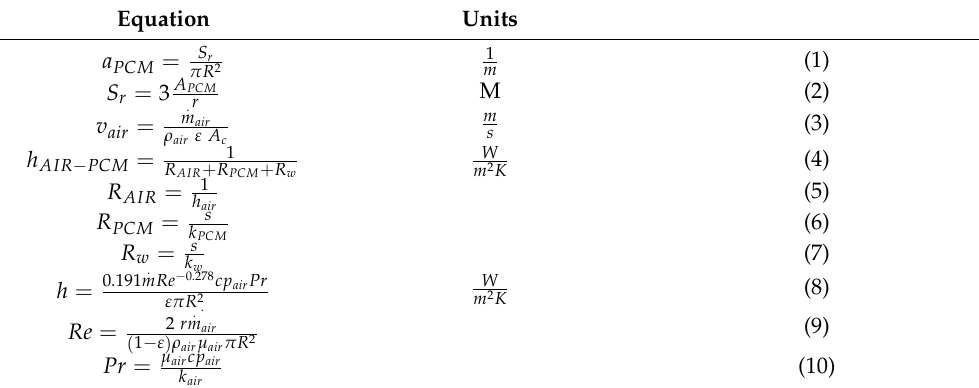
Table 3. Equations necessary to determine: Reynolds, Prandtl numbers, and the heat exchange global coefficient (P = 5 bar, T = 420 ◦ C).